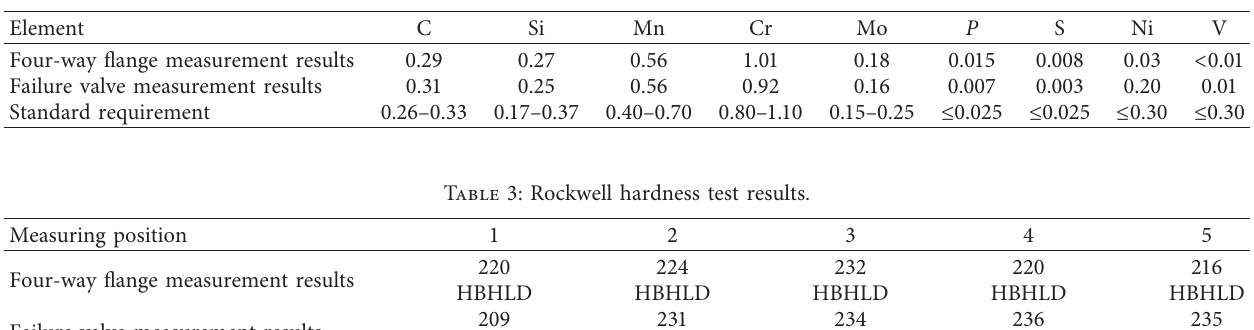
Table 2: Chemical composition of the four-way flange and connecting valve.